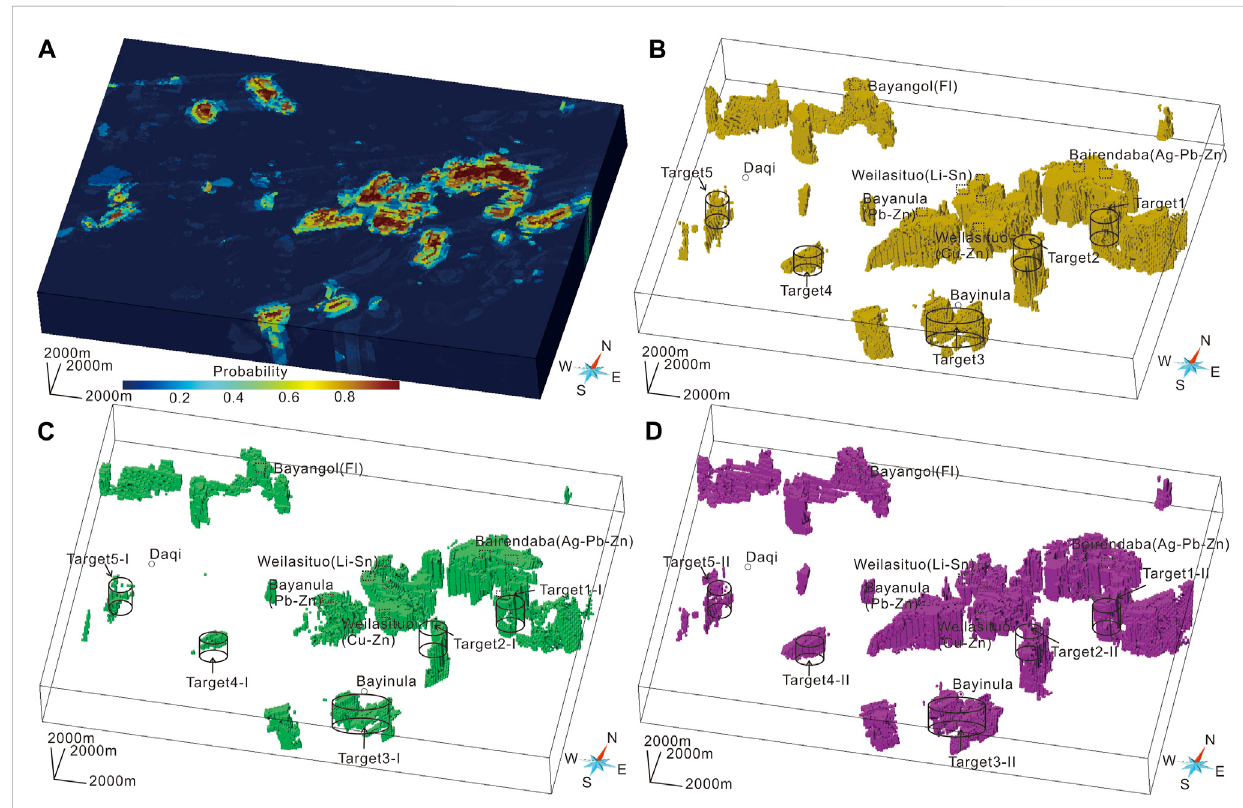
FIGURE 12 (A) 3D mineral probability map of the RF28 predictive model; and (B) targets by P-A plot; (C) Ⅰ -level targets and (D) Ⅱ -level targets by C-A